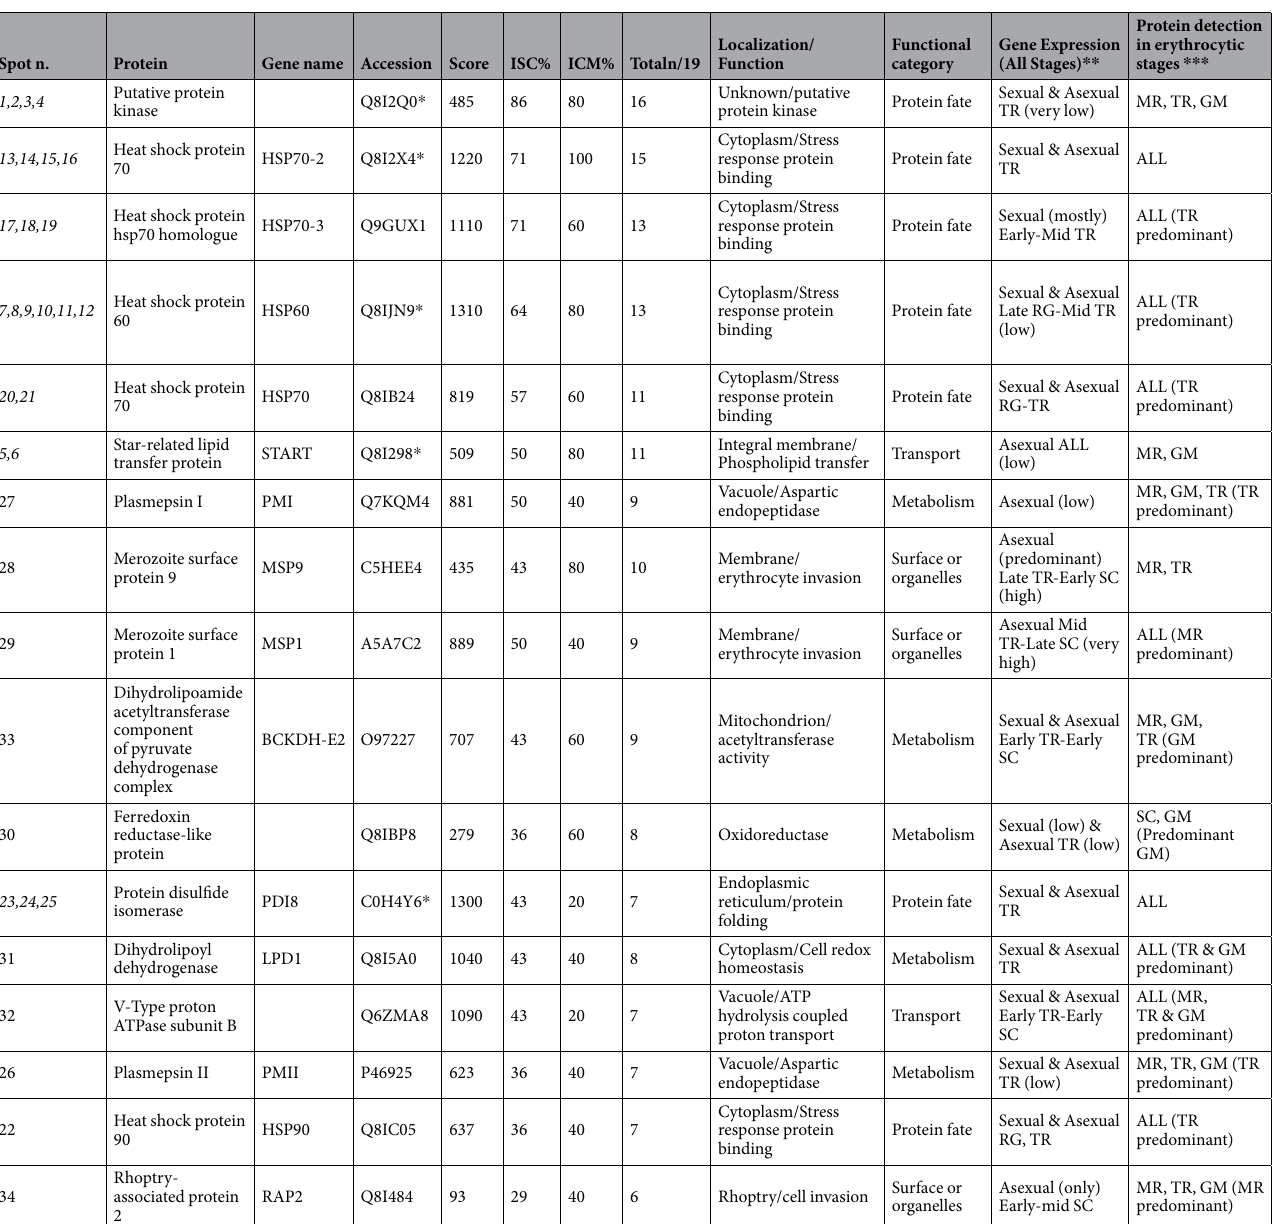
Table 1. Immunoproteomics-based identification of P. falciparum proteins that showed IgG reactivity with serum samples from malaria patients. Gene name, Accession No., and identification score is provided. Columns ISC and ICM indicates the percentage of individual Western blots where the protein spot showed up using patient sera from each group, ISC and ICM. Under column “Total” is given the total number of different patient sera used in Western blots where the protein spot showed up. A total number of 19 different Western blots were run including both groups. Information on each antigen includes its functional category and the developmental stages where its gene expression and protein have been detected from previous studies 32,50 . An asterisk under “Accession” indicate those proteins selected for epitope mapping. Two asterisks under “Gene expression” compile data on stage expression from the Malaria Cell Atlas 50 as follows: Ring (RG), Trophozoite (TR), Schizont (SC), All Asexual Stages (ALL). Three asterisks under “Protein detection in erythrocytic stages” compile data on stage expression from 32 as follows: Ring (RG), Trophozoite (TR), Schizont (SC), Merozoite (MR), Gametocyte (GM), All Erythrocytic Stages